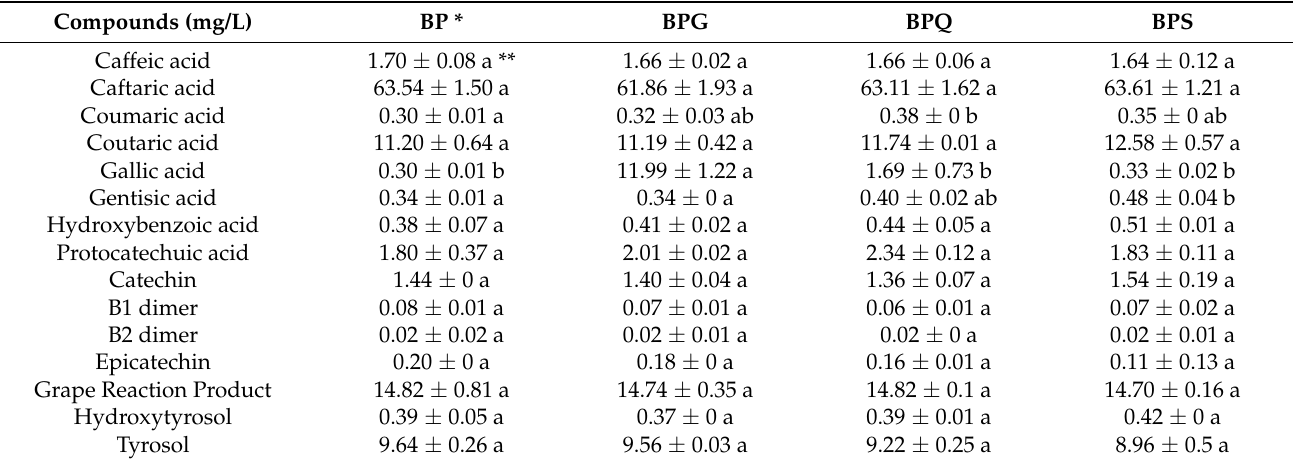
Table 4. Aged wines’ phenolic